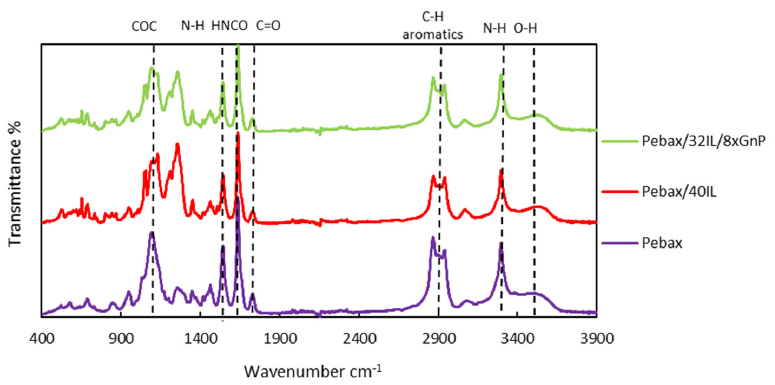
Figure 4. FTIR spectra of pure Pebax ® 1657, the CILPM Pebax/40IL and the mixed-matrix membrane (MMM) Pebax/32IL/8xGnP studied in this work—full names in Table 1. Pebax ® 1657 characteristic peaks are identified.